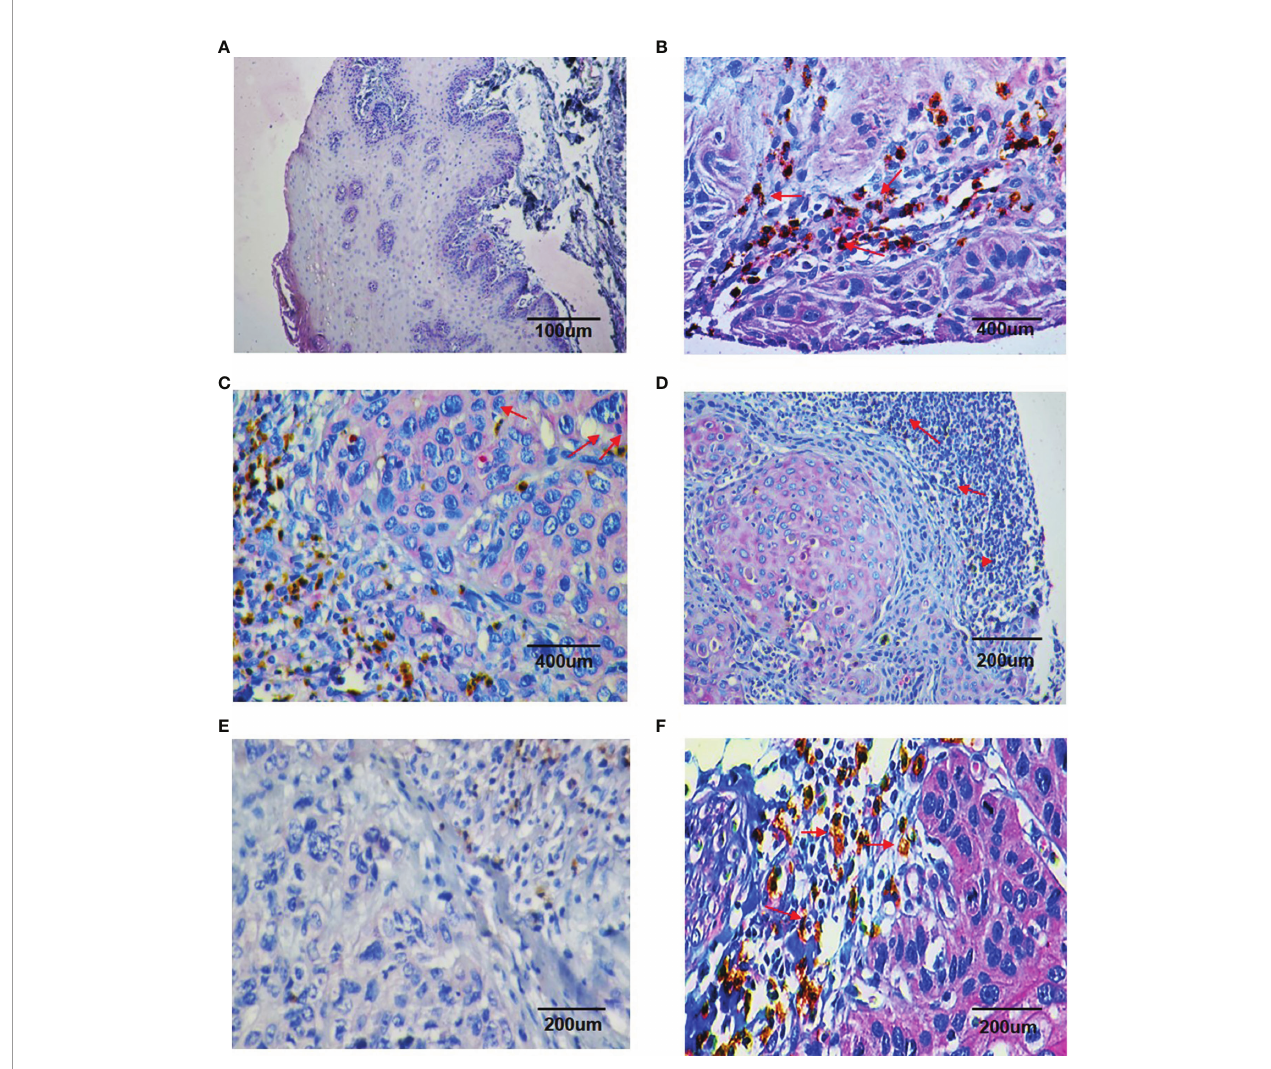
FIGURE 1 | Double staining immunohistochemistry results of CD15 + TANs and Chemerin. (A – D) The results showed more CD15 + TANs (red arrow) in fi ltrated in OSCC tissues (B – D) than in peritumoral tissues (A) , with TANs predominantly observed in stroma around the carcinoma nests (B) , within the carcinoma nests (C) and in the borderline of tumor invasion (D) . (A, 100×; B, C, 400×; D, 200×). Chemerin (pink color) was absent or weakly expressed in peritumoral non-neoplastic tissues (A) , whereas its expression was upregulated in cancer tissues compared with peritumoral tissues and located mainly in the cytoplasm of tumor cells (B – D) . (E, F) The relationship of Chemerin expression on tumor cells and in fi ltration of TANs. In negative or weak Chemerin expression tumors, there were relatively fewer TANs (E) ; while in strong Chemerin expression tumors, there were more TANs (red arrow) (F) . (E, F, 200×). Brown: CD15 + (DAB staining), Pink: Chemerin (GBI